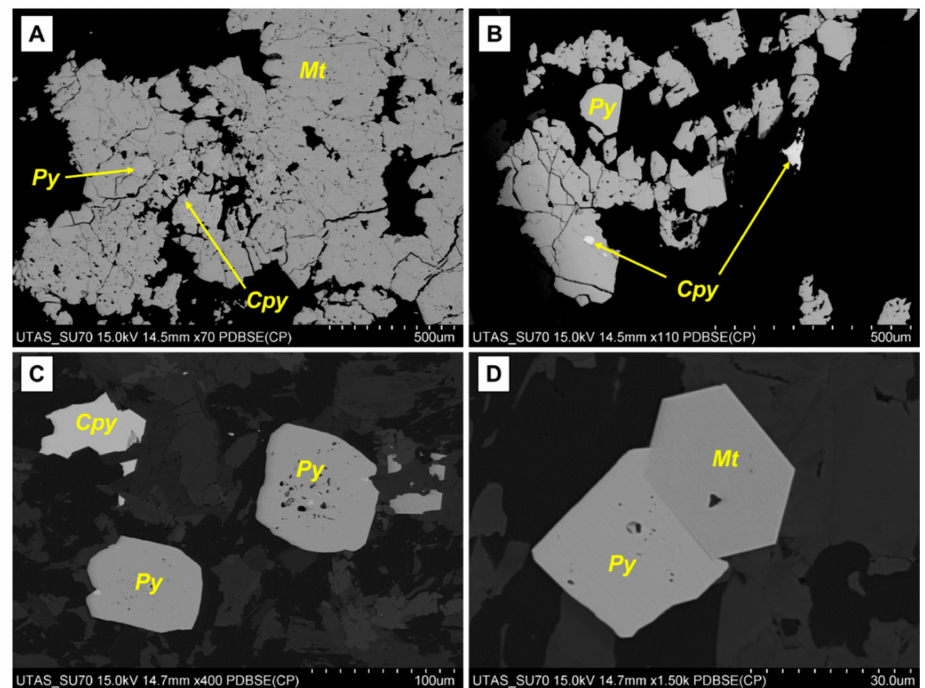
Figure 2. Back scattered electron images of Savage River ore and sulphide gangue; ( A ) Massive magnetite containing pyrite and chalcopyrite intergrowths; ( B ) Massive pyrite containing chalcopyrite blebs; ( C ) Pyrite and chalcopyrite in a silicate matrix; and ( D ) Pyrite-associated magnetite grains (abbreviations: Cpy, chalcopyrite; Mt, magnetite; Py,